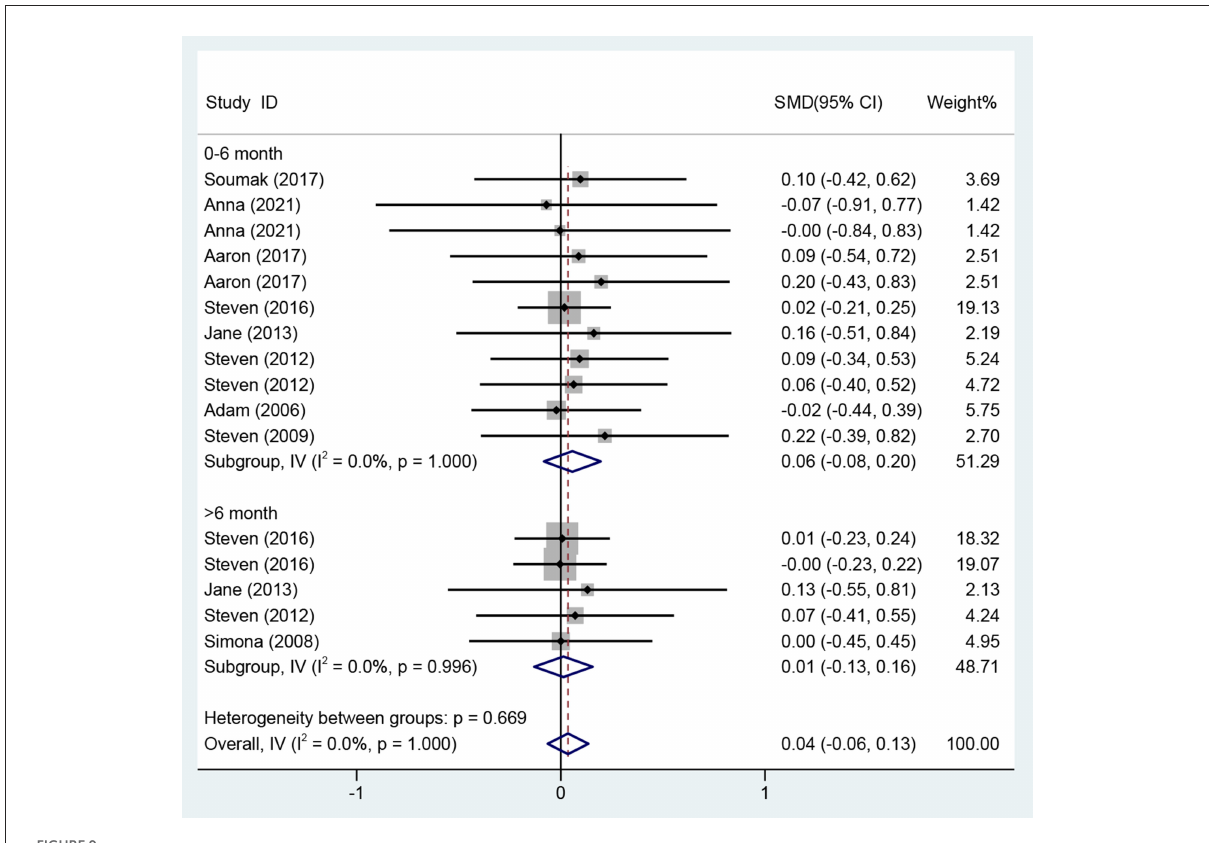
FIGURE9 Forest diagram of